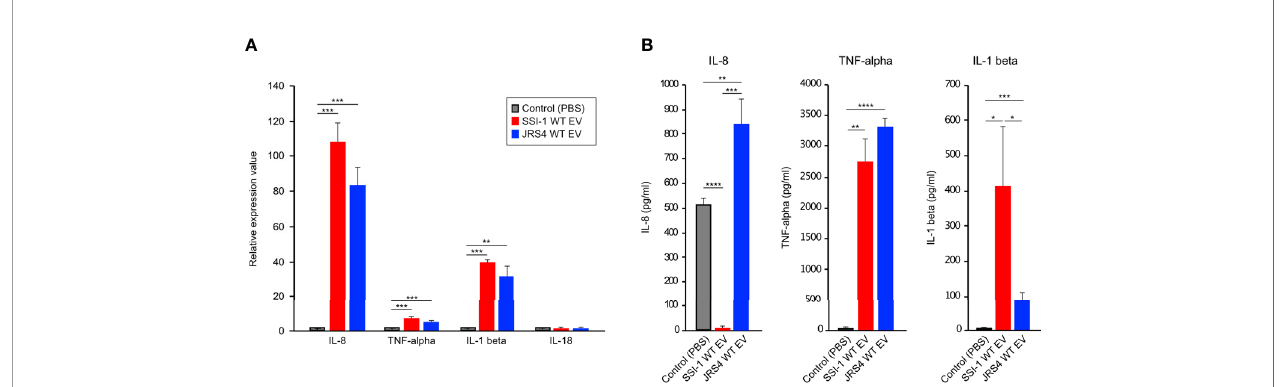
FIGURE 5 | Induction of cytokine expression in dTHP-1 cells treated with GAS EVs. 10 µg of EVs solution was treated with dTHP-1 cells and incubated for 4 h at 37°C. Total RNA extracted from the cells were used for transcriptional level of IL-8, TNF- a , IL-1 beta, and IL-18 by using real-time PCR assay (A) , and the supernatants were directly used for ELISA assays of IL-8, TNF- a , IL-1 beta (B) . PBS-treated dTHP-1 cells were used as a control for the experiments, and all experiments were performed in triplicate. Data in this analysis represent the mean ± SEM of independent experiments. P-values calculated by two-tailed Student ’ s